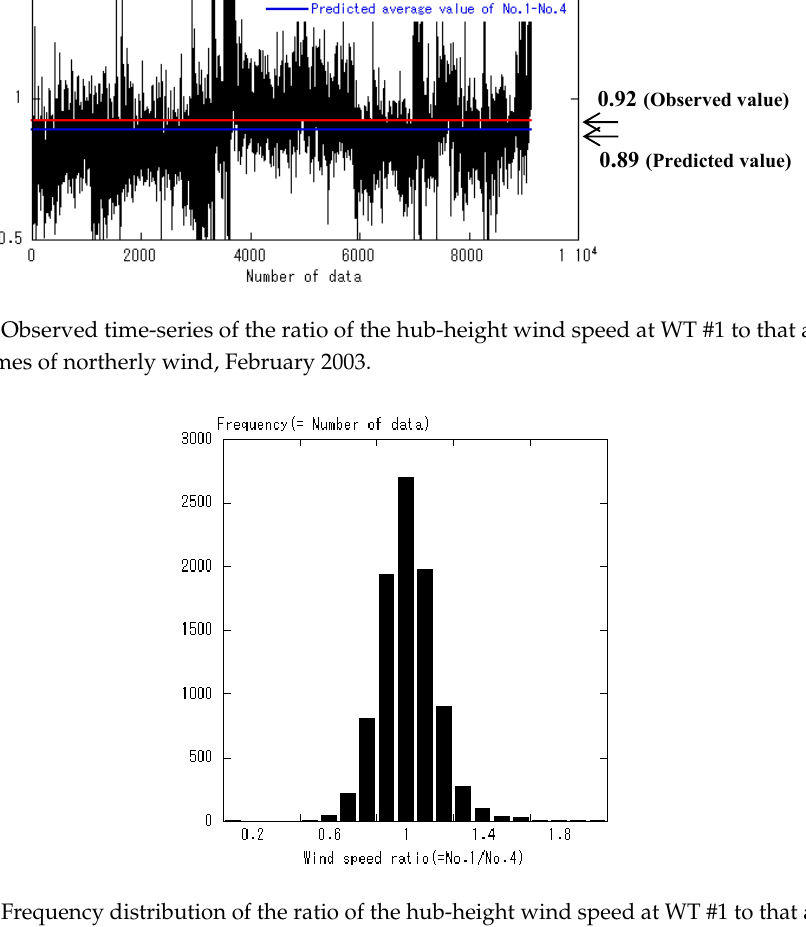
Figure 15. Frequency distribution of the ratio of the hub-height wind speed at WT #1 to that at WT #4, only for times of northerly wind, February 2003.